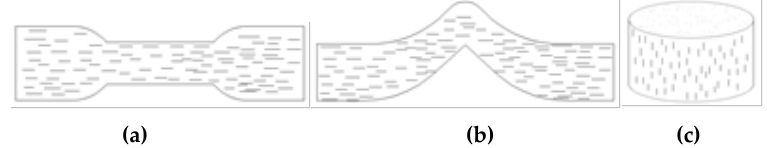
Figure 6. The testing specimen : ( a ) Sample for tensile; ( b ) Sample for tear; (c ) Sample for wear